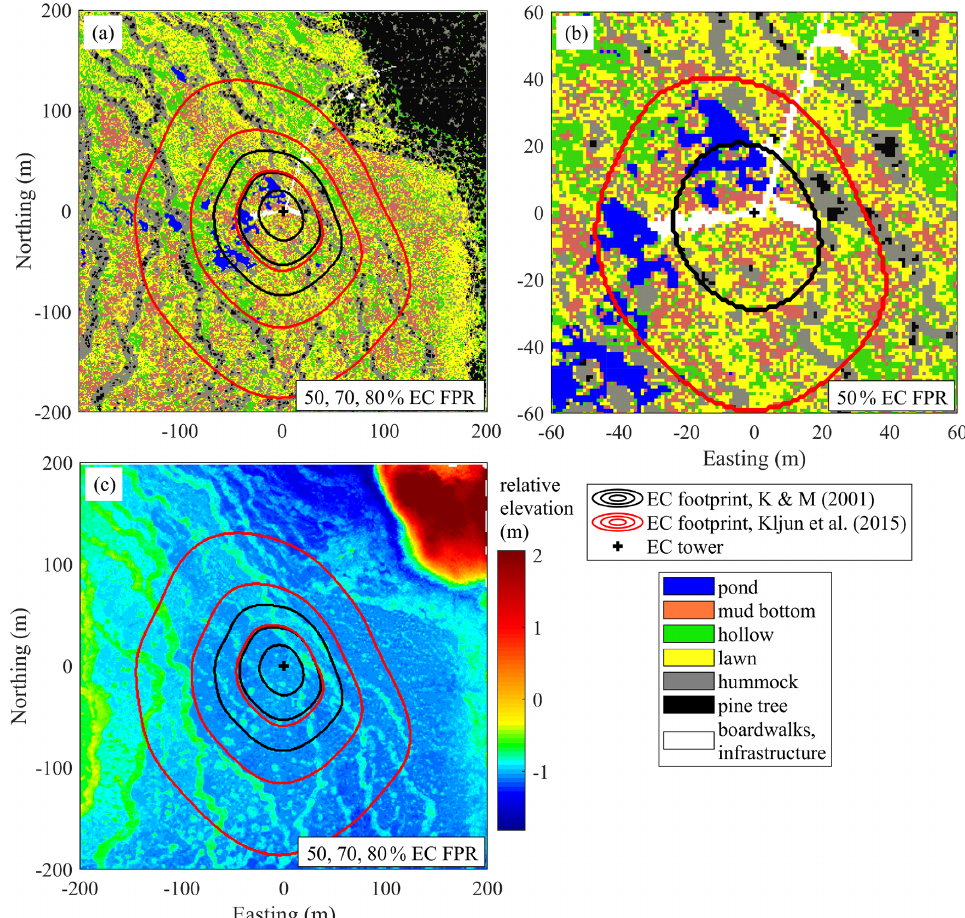
Figure 2. Site characteristics obtained from the helicopter survey in May 2013. (a) Surface cover map at 1m resolution showing a 400 × 400m patch of landscape centered on the EC tower. The cumulative Kormann and Meixner (2001) and Kljun et al. (2015) flux footprints are given by 50, 70 and 80% contribution contours. (b) Close-up map, focusing on the 50% cumulative footprint zones. (c) Digital elevation model derived from a lidar scan. Note that the 70% Kljun et al. (2015) isoline coincides with the 50% Kormann and Meixner (2001) isoline. FPR – footprint. Table 2. Proportions of the surface types and microforms, expressed as area percentage (first column) or weighted by the cumulative foot- prints, Kormann and Meixner (2001) and Kljun et al. (2015) (second and third columns).